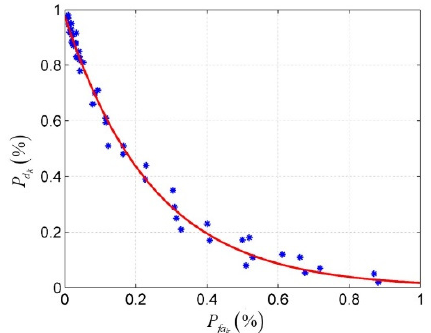
P and P . Figure 5. The relationship between P fa k and P d k k fa k d